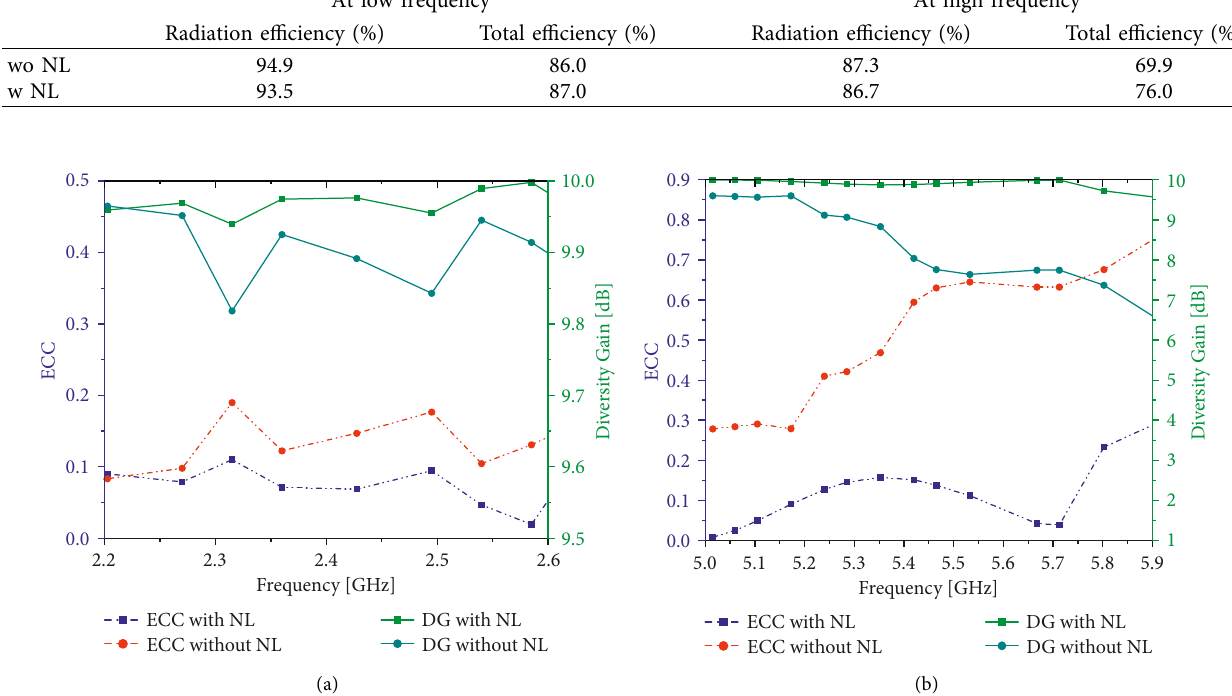
Figure 17: The ECC and DG of the proposed antenna#2 with and without NL: (a) 2.4GHz and (b)